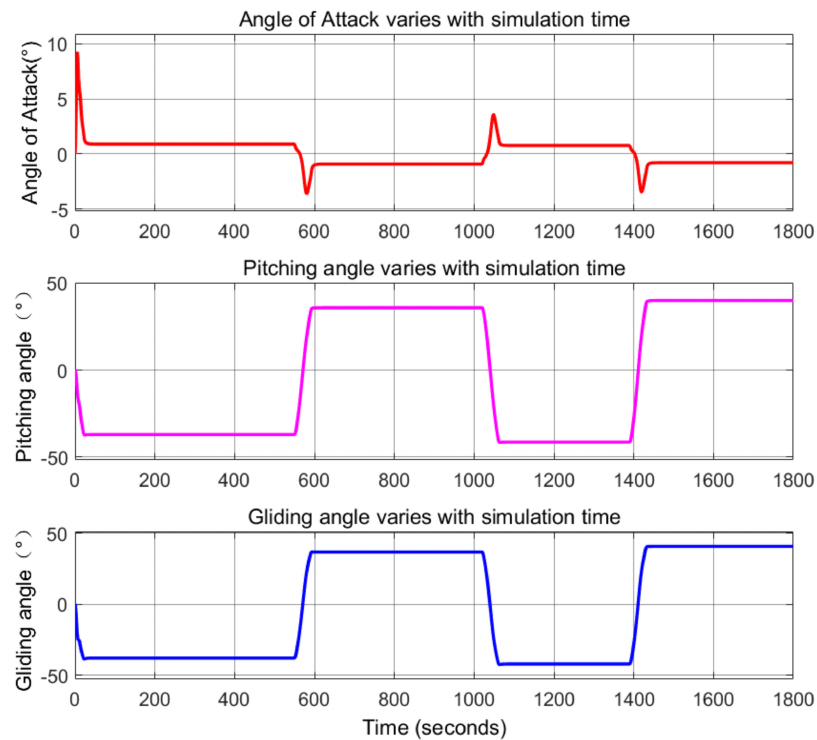
Figure 7. Change in angle with simulation